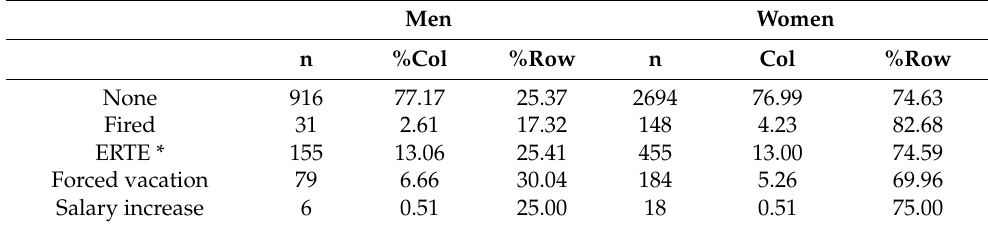
Table 5. Relationship between contractual changes and